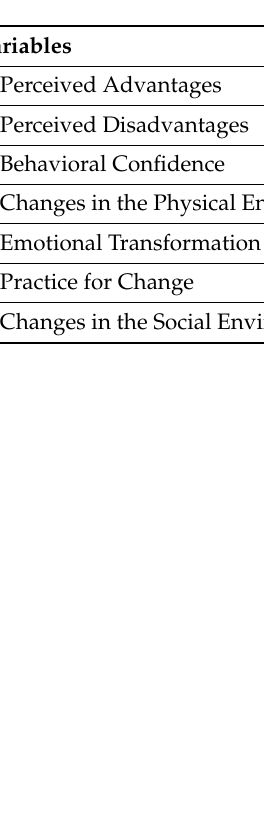
Table 3. Bivariate correlations and reliability diagnostics for MTM variables ( N =